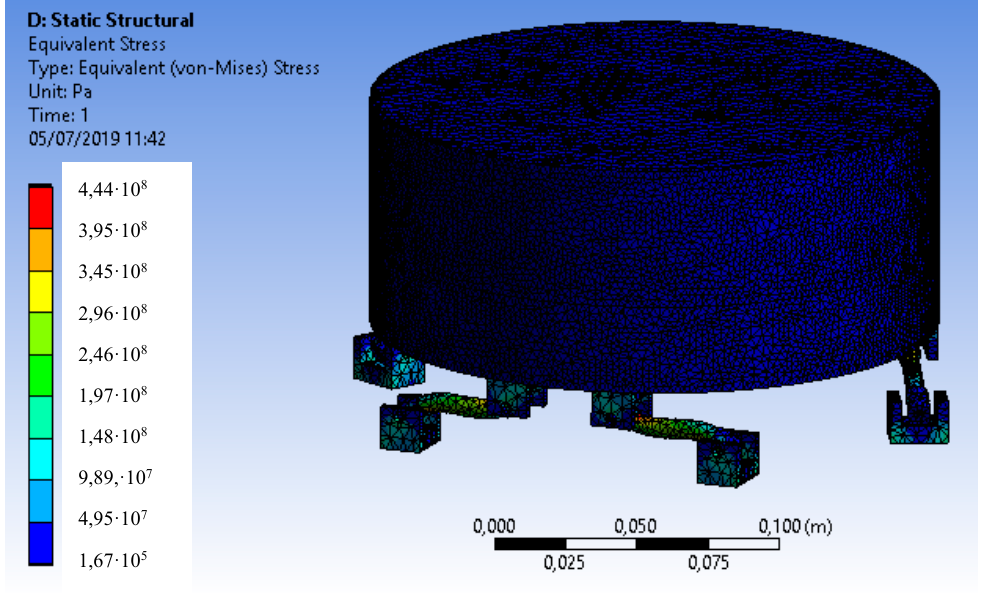
Figure 9. Structural steady-state simulation results: Maximum equivalent stress of 444 MPa.